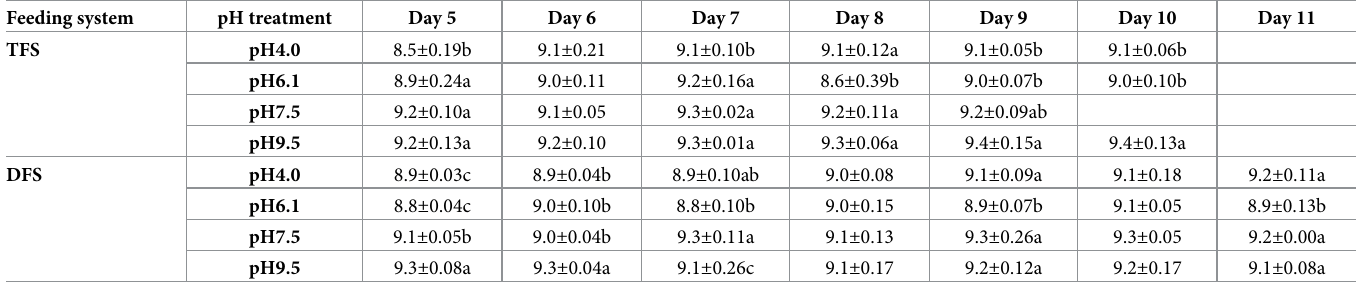
Table 2. Variation in the pH values (mean ± SD) from 5 Th day to end of the trial for the different initial pHs (pH4.0; pH6.1; pH7.5; pH9.5) and feeding systems (TFS: Total amount of diet provided at the beginning (480g on WB); DFS: Daily allocated diet (40g/d on WB)). Different letters within a column indicate significant difference ( P (cid:20)